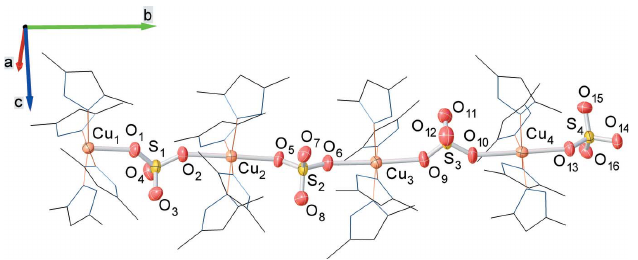
Figure 2 The asymmetric unit of the title compound. Selected pyrazole ring atoms are represented as wireframes. H atoms and hydrogen bonds are omitted for clarity.